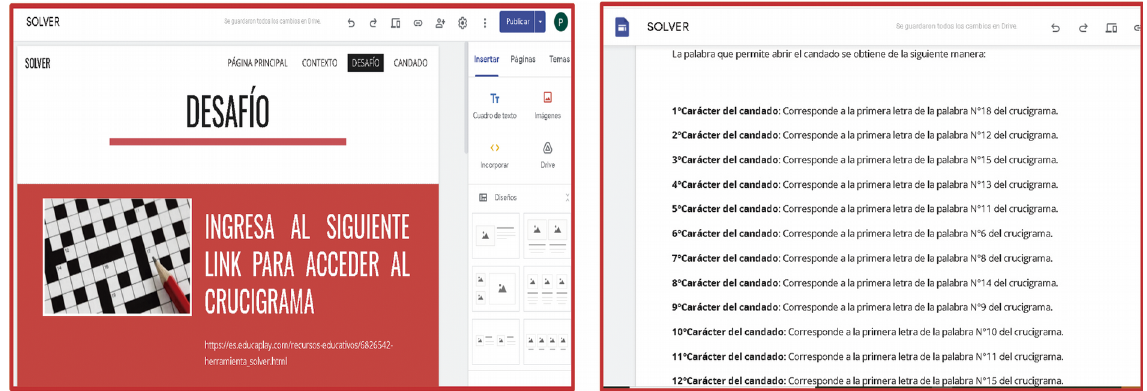
Figure 9. Crossword puzzle of the use of Operations Research and Solver https://bit.ly/3IyCNyX